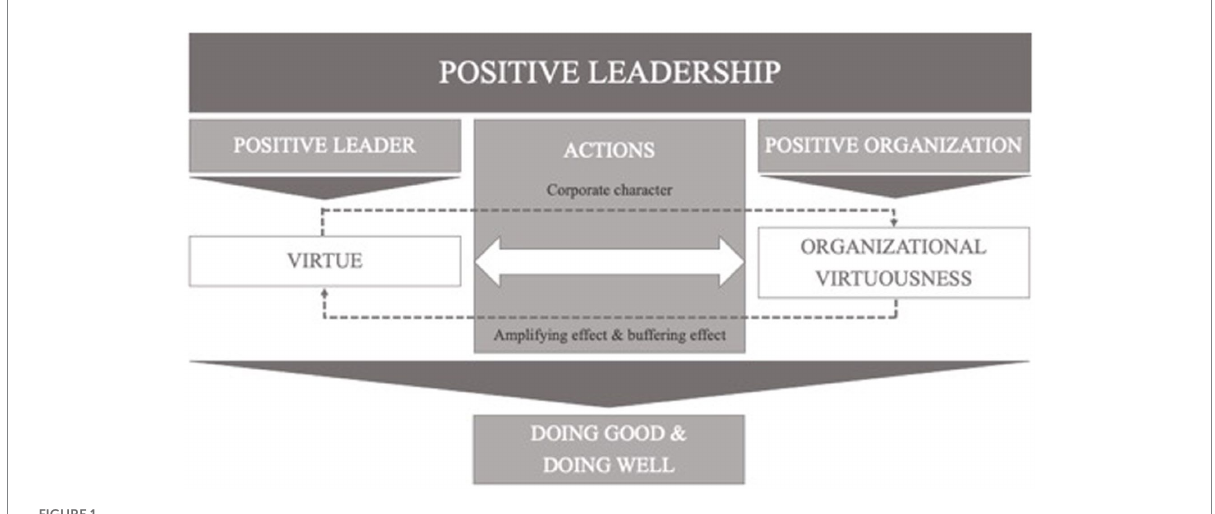
FIGURE 1 The building blocks of the